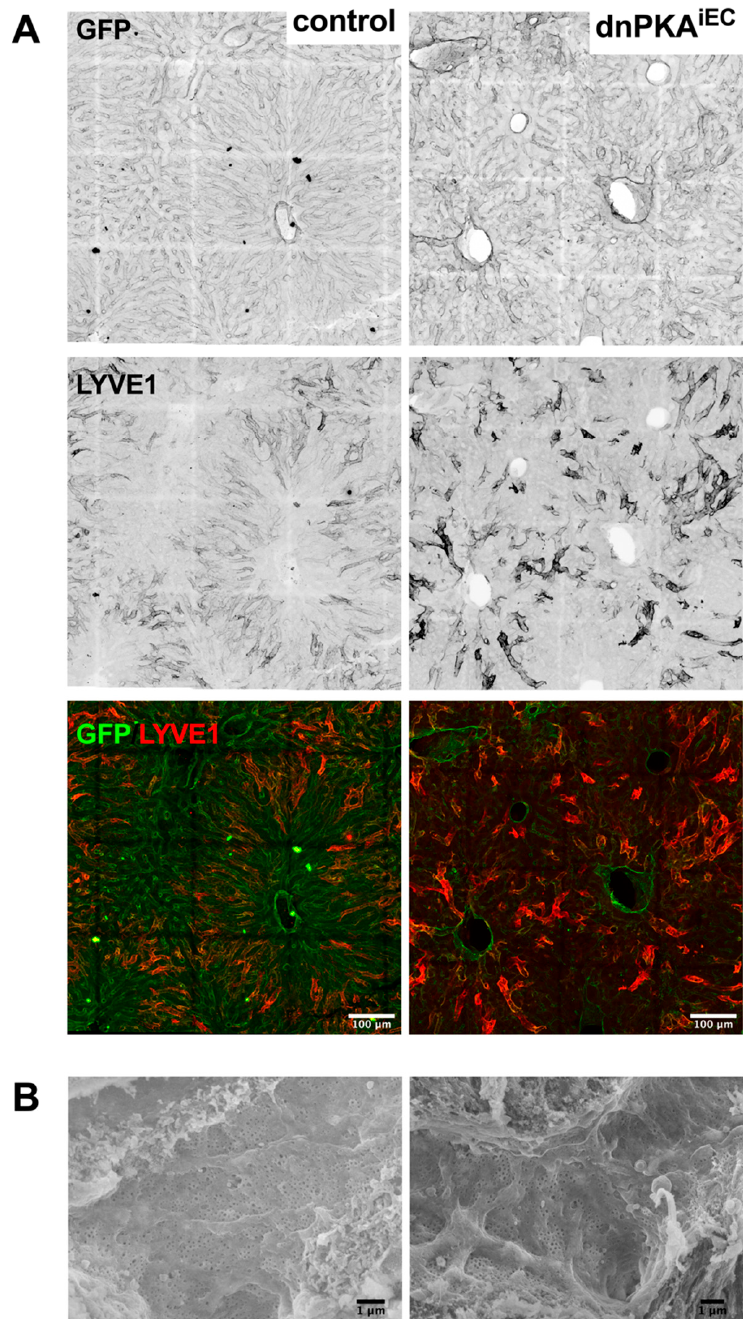
Figure 12. Liver sinusoidal cells in dnPKA iEC mice preserve their biochemical and morphological features ( A ), despite disorganization of the hepatic vasculature, LYVE1, a marker of liver sinusoidal cells (LSECs) was expressed and even increased in dnPKA iEC mice. Scale bar, 100 µm. ( B ), LSECs in dnPKA iEC mice also preserved fenestration, which is a feature that is lost during the pathological dedifferentiation of hepatic vasculature. Porosity of liver sinusoids (see Materials and Methods section) was 3.8 ± 0.3% (n = 5) for control mice and 4.1 ± 1.7% (n = 4) for dnPKA iEC mice. Scale bar, 1 µm. Control (Tg(Cdh5-cre/ERT2)1Rha carrying mT/mG transgene) mice and dnPKA iEC mice carrying the mT/mG reporter were injected with tamoxifen at the age of 28–32 days and dissected at the age of 65–74 days.